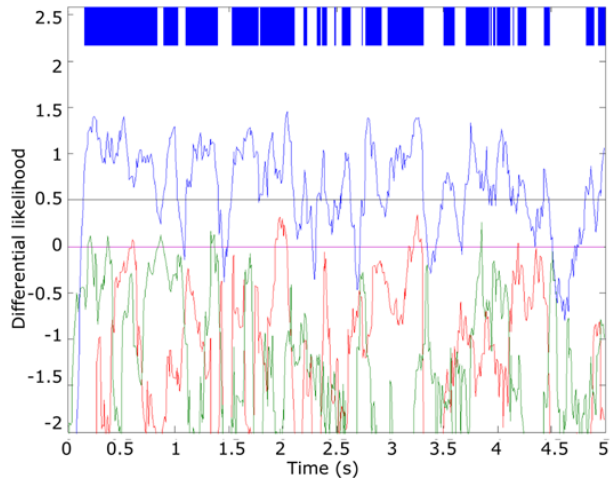
Figure 15. Result of the threshold application.